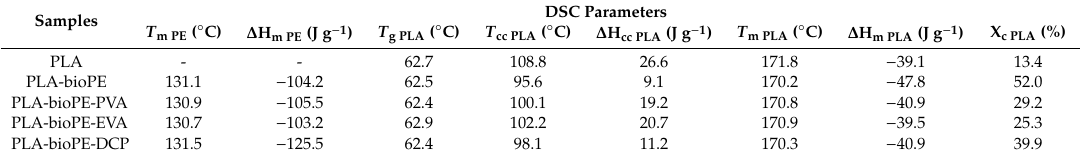
Figure 4. DSC curves of the second heating cycle of neat PLA, PLA-bioPE blend, and PLA-bioPE blend compatibilized with PVA, EVA, and DCP. Table 2. Di ff erential scanning calorimetry (DSC) parameters of neat PLA, PLA-bioPE blend, and PLA-bioPE blend compatibilized with PVA, EVA, and